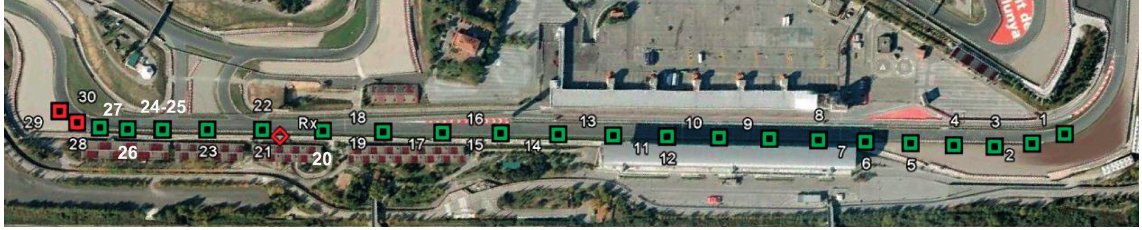
Figure 10. Remote name requests received at the Circuit the Catalunya speed circuit.